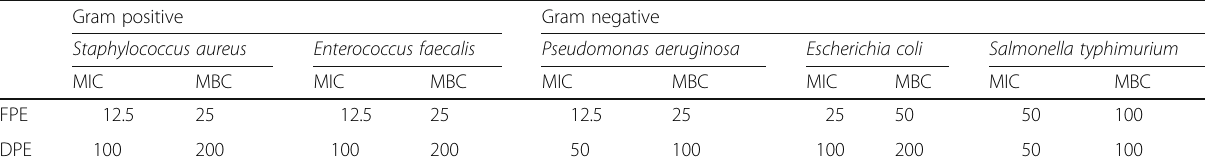
Table 3 Minimum inhibitory and bactericidal concentrations of Citrus sinensis peel extracts against some bacterial strains expressed in μ g/mL